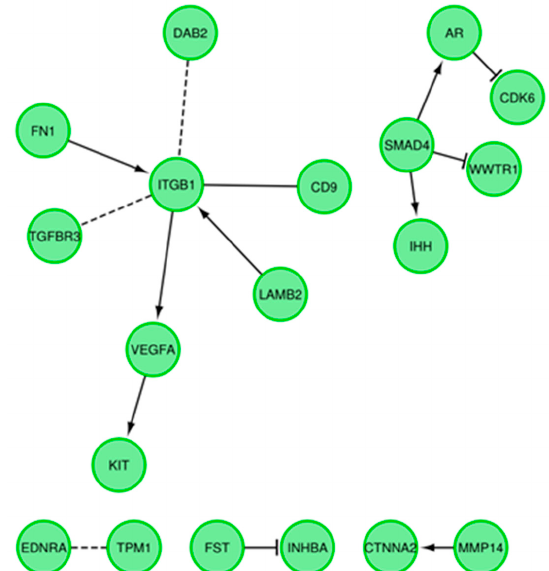
Figure 9. Functional interaction (FI) between differently expressed genes that belong to “cellular component morphogenesis”, “negative regulation of cell differentiation”, “morphogenesis of a branching structure”, “regulation of cellular component size”, and “branching morphogenesis of a tube” GO BP terms. In following figure “->” stands for activating/catalyzing, “-|” for inhibition, “-” for FIs extracted from complexes or inputs, and “---” for predicted FIs.